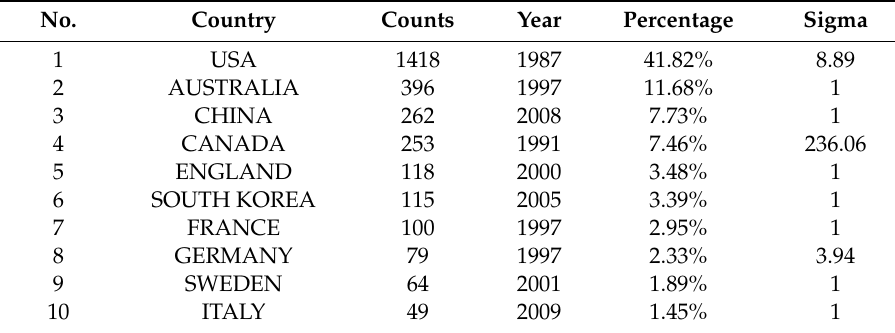
Table 1. Top 10 countries / areas with the most published documents.